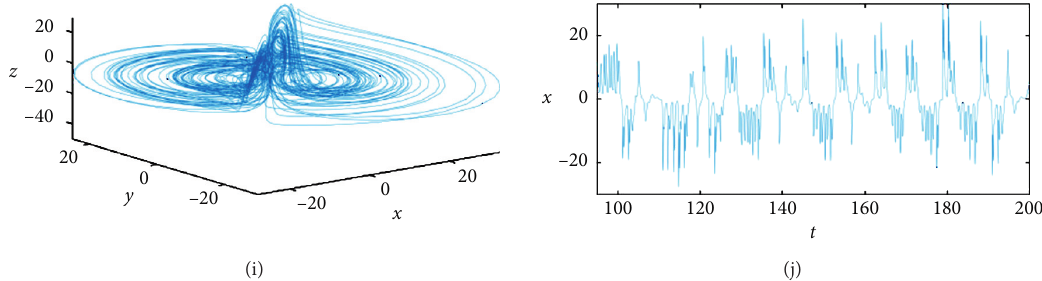
Figure 2: Phase diagram and time course diagram of the system when the delay value τ takes different values. (a) System phase diagram at τ � 0.02. (b) Time course diagram at τ � 0.02. (c) Phase diagram of the system at τ � 0.25. (d) Time course diagram at τ � 0.25. (e) System phase diagram at τ � 0.5. (f) Time course diagram at τ � 0.5. (g) System phase diagram at τ � 1. (h) Time course diagram at τ � 1. (i) System phase diagram at τ � 1.3. (j) Time course diagram at τ � 1.3.